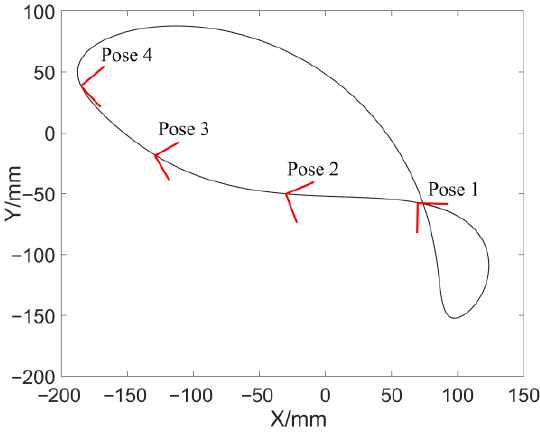
Figure 16. Verification of simulation results.